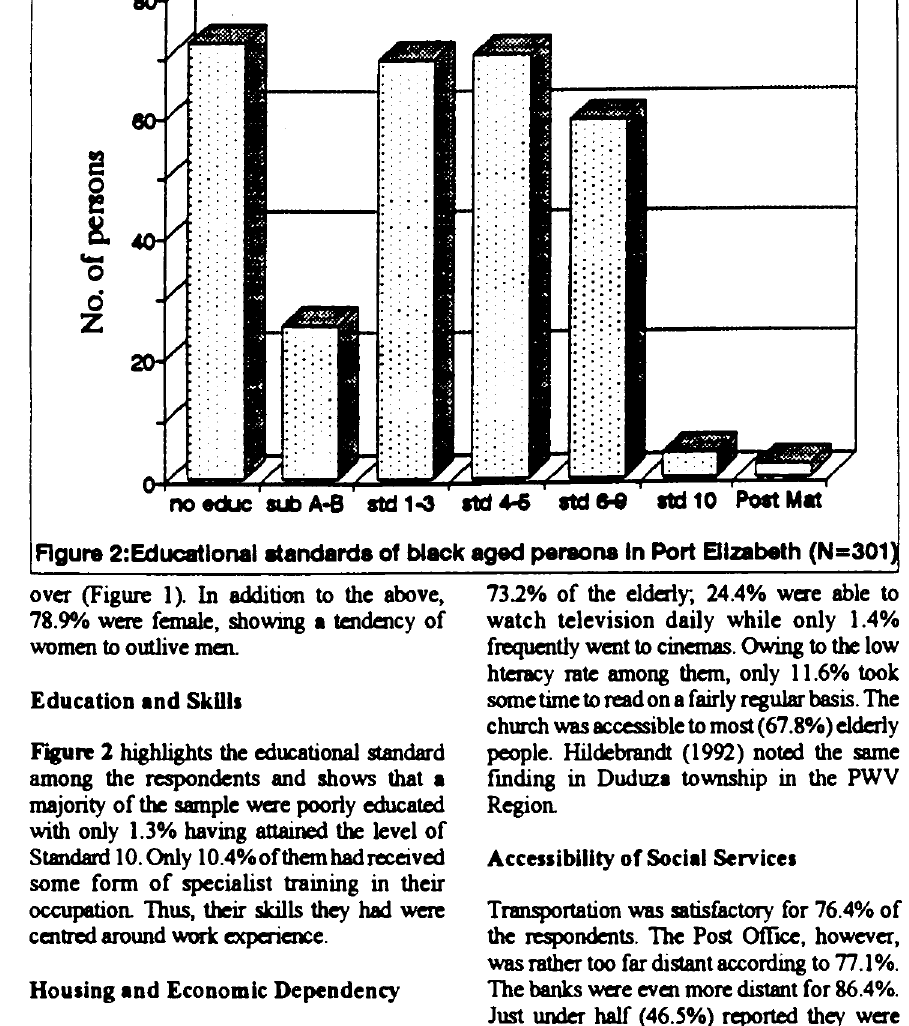
Table 4: A coessibllity of social services of the black aged